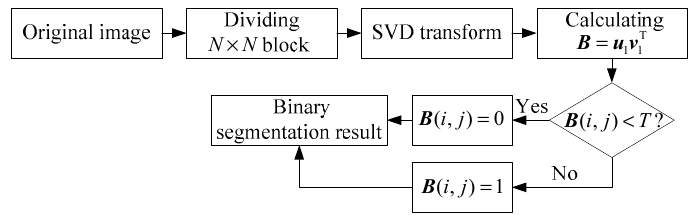
Figure 2. The process of image segmentation.